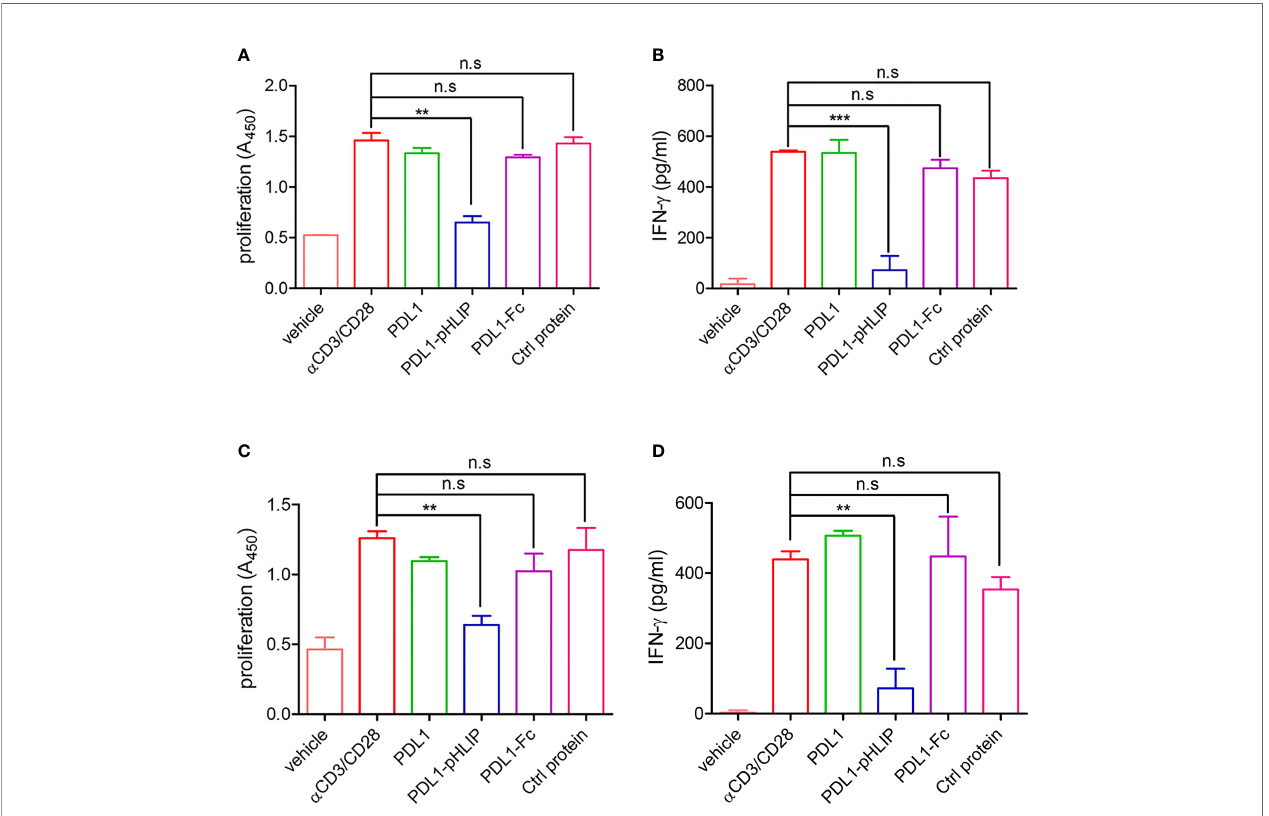
FIGURE 6 | The capacity of soluble PD-L1-pHLIP to inhibit lymphocyte proliferation and IFN- g production under acidic conditions. (A, B) Mouse lymphocytes were stimulated with a CD3/CD28 antibodies in the presence of soluble PD-L1/PD-L1-pHLIP/PD-L1-Fc (0.1 m g/ml) for 72 h in pH 6.3 buffer. The proliferation was determined by BrdU cell proliferation assays (A) . IFN- g production in the supernatants was examined by ELISA (B) . (C, D) Mouse lymphocytes were stimulated with a CD3/CD28 antibodies in the presence of soluble PD-L1/PD-L1-pHLIP/PD-L1-Fc (0.1 m g/ml) for 72 h in buffer containing 10 mM lactic acid. The proliferation was determined by BrdU cell proliferation assays (C) . IFN- g production in the supernatants was examined by ELISA (D) . The data were pooled from fi ve independent experiments with similar results. ** p < 0.01; *** p < 0.001; n.s., no signi fi